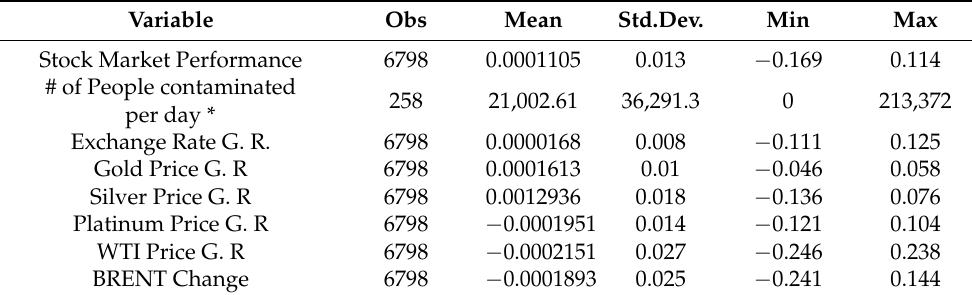
Table 2. Descriptive Statistics.